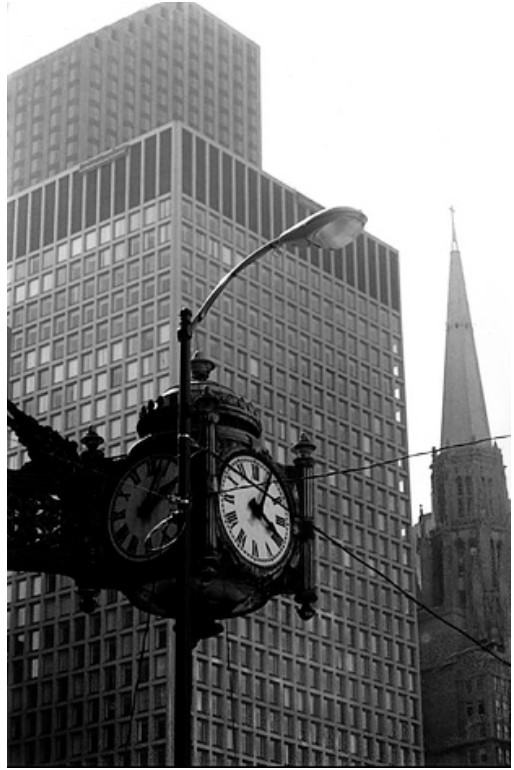
Figure 7. There are three subject matters that are juxtaposed into this one frame; the clock, the modern skyscraper, and the old chapel, taken in downtown